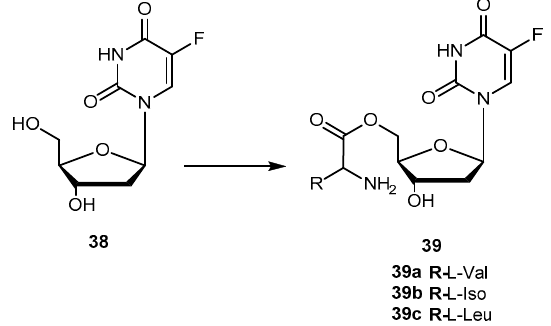
Figure 17. Structures of amino acid ester prodrugs of floxuridine ( 38 ).